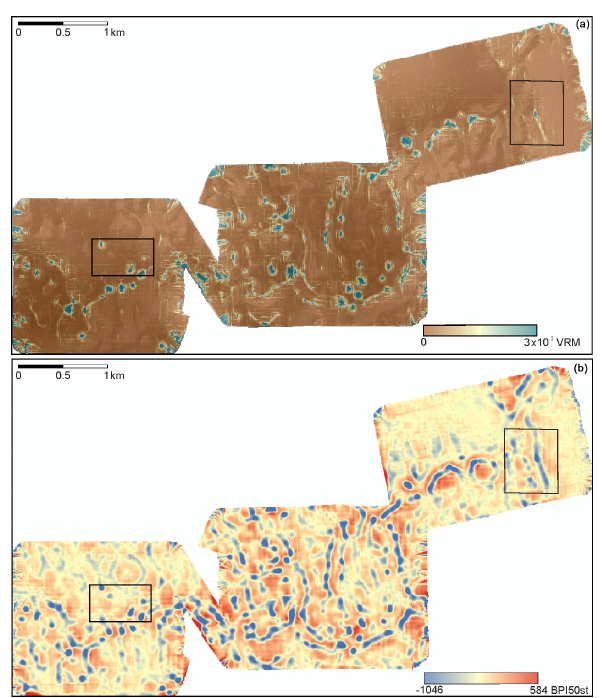
Figure A4. (a) Terrain-roughness-indicating map derived from AUV-acquired bathymetry data (calculated with the VRM algorithm) (Sap- pington et al., 2007). (b) BPI50st derived from the AUV-obtained bathymetric data set; the lowest values indicate areas with pit structures that are observed throughout the entire